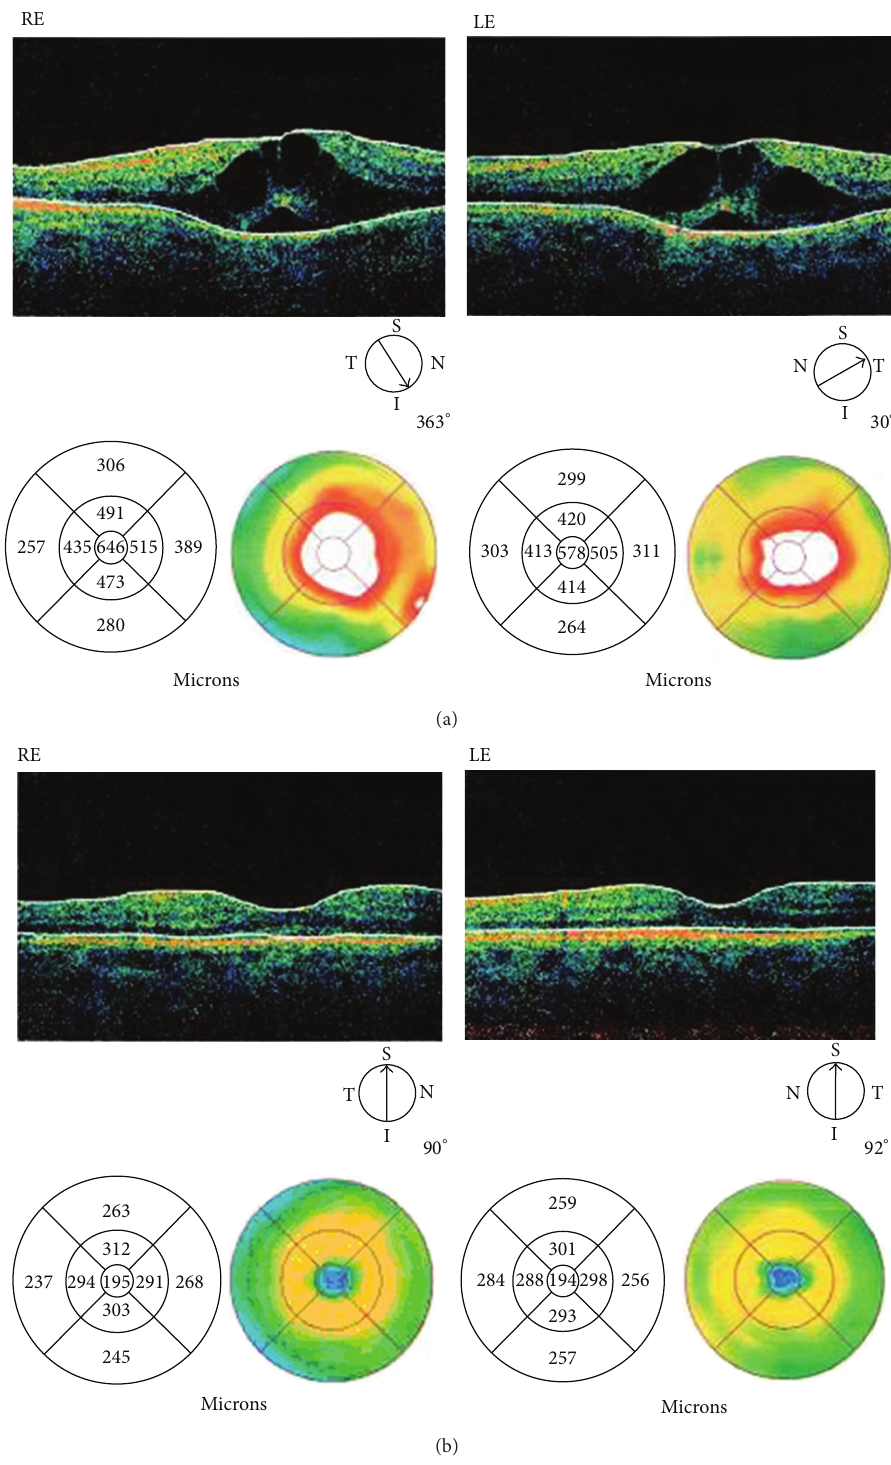
Figure 1: (a) Stratus OCT during niacin treatment. Abnormal retinal profile with the presence of hyporeflective cystoid spaces in the outer plexiform and inner nuclear layers in both eyes. Central macular thickness (CMT) was 646 microns in RE and 578 microns in LE. (b) Stratus OCT four weeks after discontinuation of therapy. Normal retinal thickness with complete disappearance of the hyporeflective cystoid spaces. Central macular thickness (CMT) was 195 microns in RE and 194 microns in